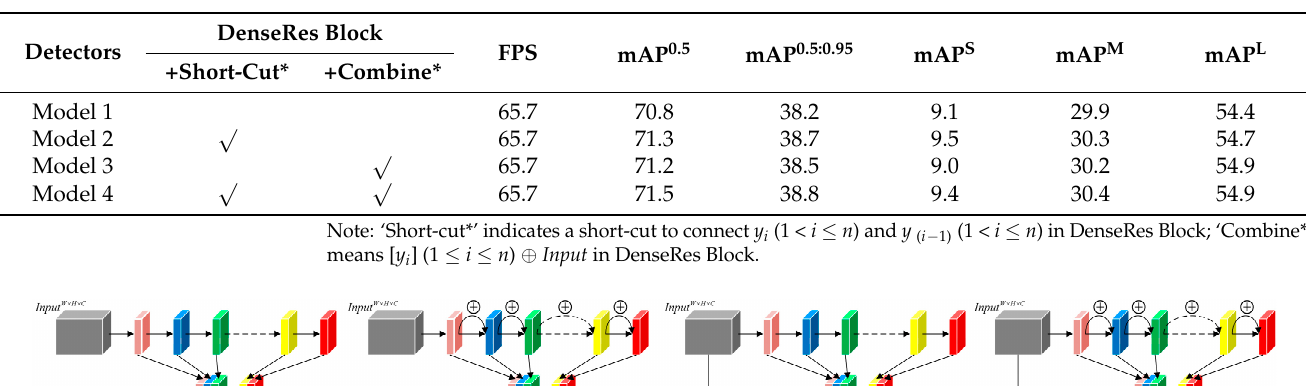
Table 3. The ablation results of DenseRes Block.